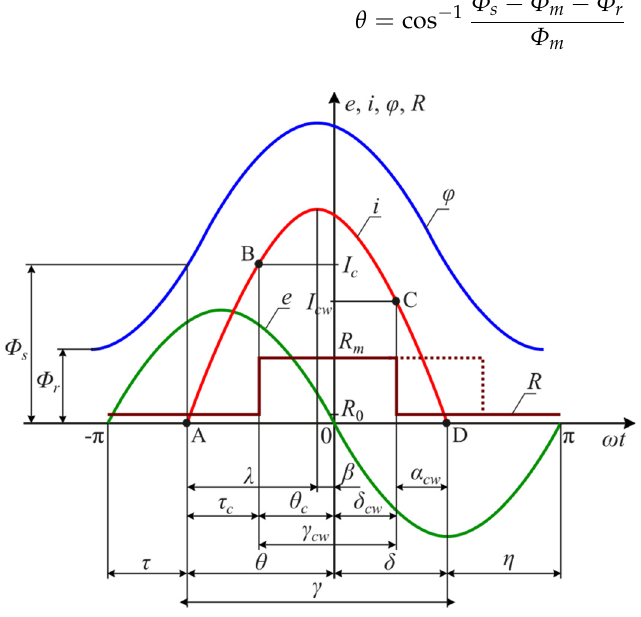
7 of 19 Figure 6. Replacement diagram of HTS transformer at core saturation. The unidirectional current appears when the momentary value of the flux ϕ exceeds the value of the saturation flux of the core Φ n , which takes place for ω t = − θ (Figure 7). By converting Equation (13), including ω t = − θ and ϕ = Φ n , a formula is obtained for the angle at which the unidirectional current pulse appears: m rms Φ ΦΦΦ −− = − 1 cos θ